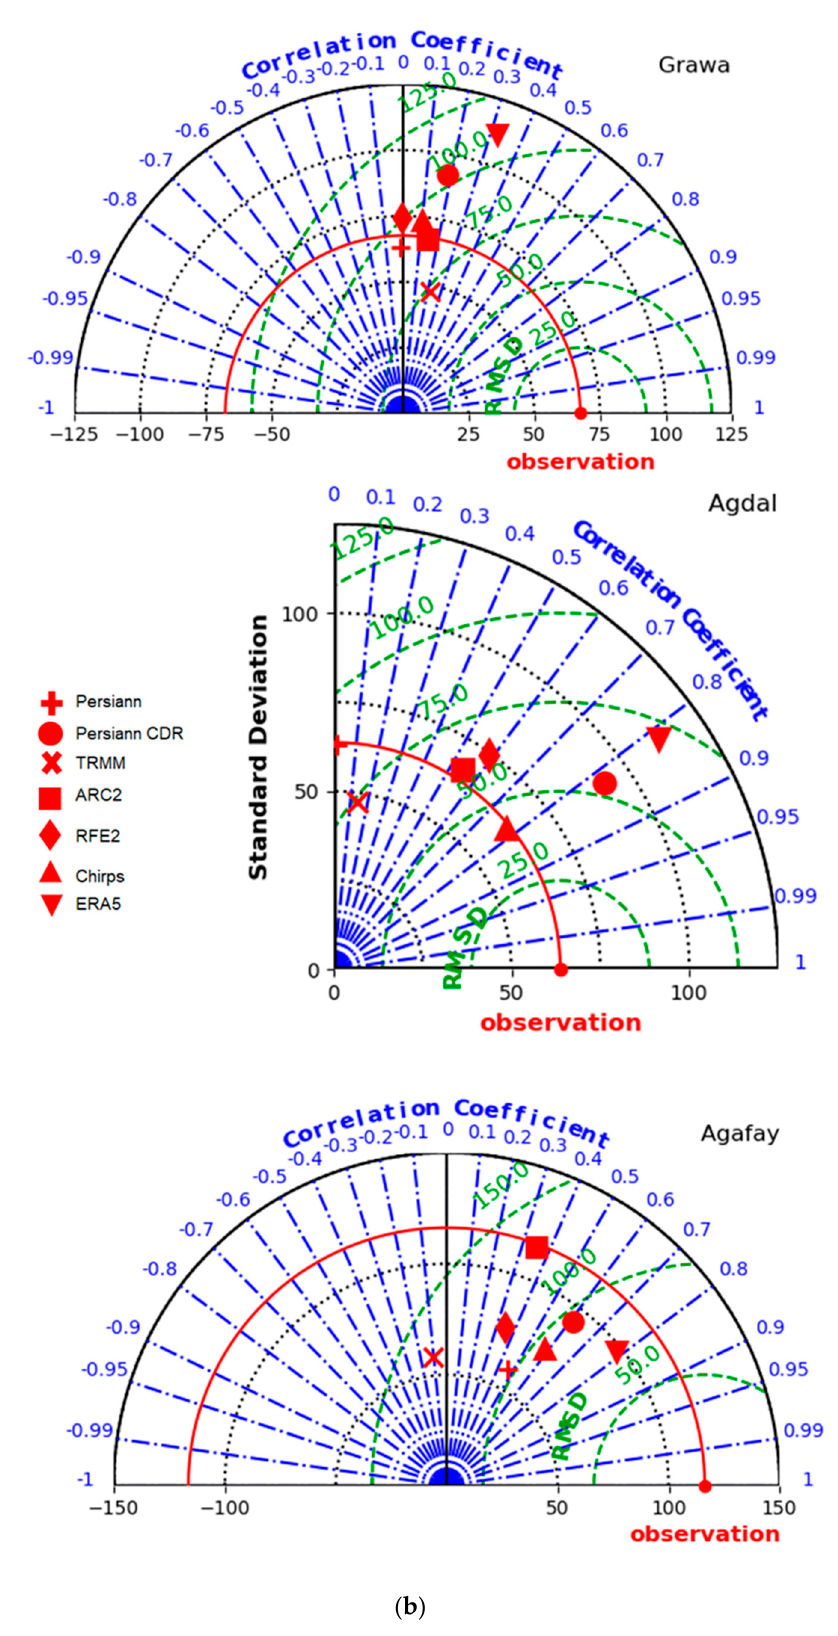
Figure 9. ( a ) Taylor diagram of the annual precipitation at Tachedert, Imskerbour, and Asni weather stations; ( b ) Taylor diagram of annual the precipitation at Grawa, Agdal, and Agafay weather